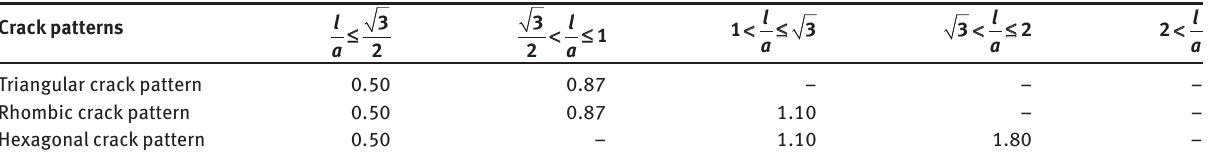
Table 1: Selection of the ratio l / a for different crack patterns. Crack patterns 3 Triangular crack pattern Rhombic crack pattern Hexagonal crack